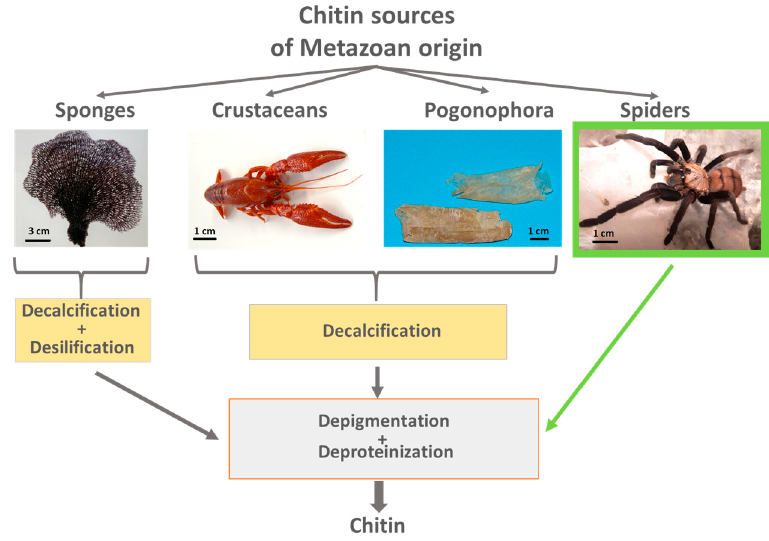
Figure 2. Principles of chitin isolation from diverse sources of metazoan origin.